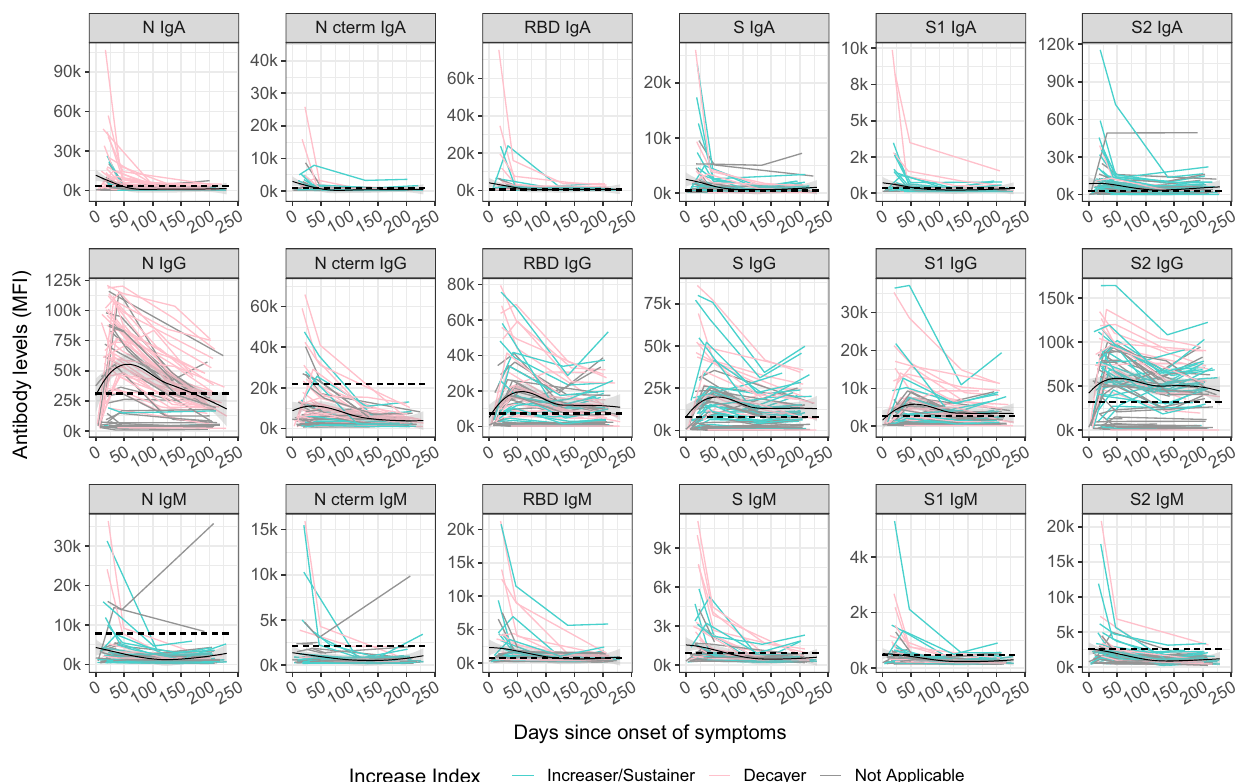
Fig. 1 Kinetics of SARS-CoV-2 antibody levels since onset of symptoms. Levels (median fl uorescence intensity, MFI) of IgA, IgG, and IgM against each antigen (Nucleocapsid full-length protein (N), and its C-terminal domain, the Receptor Binding Domain (RBD), full S protein and its subregions S1 and S2) measured in 235 samples from 76 symptomatic participants collected in up to four time points per participant (paired samples joined by lines). The black solid line represents the fi tted curve calculated using the LOESS (locally estimated scatterplot smoothing) method. Shaded areas represent 95% con fi dence intervals. Dashed line represents the positivity threshold. Participants were grouped based on their antibody levels at M6 compared to the previous visit, individuals were labeled for each isotype-antigen pair as “ Decayers ” (pink) when the ratio of antibody levels between both visits was <1 and as “ Sustainers/Increasers ” (light blue) when the ratio was ≥ 1 and gray when the classi fi cation was not